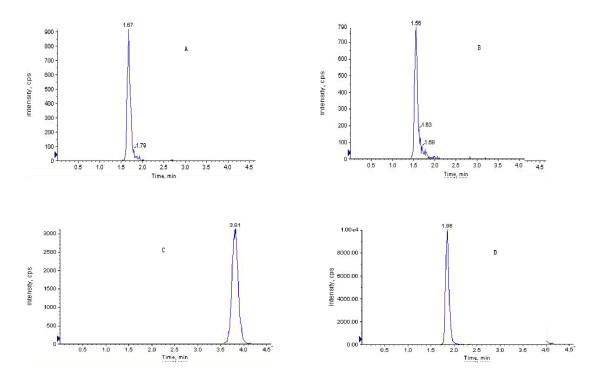
Chromatograms under LC/MS/MS conditions for analyzing beagle dog plasma spiked with Notoginsenoside R1 (A), Ginsenoside Rg1 (B), Ginsenoside Rb1 (C) and internal standard glipizide (D). MS/MS transitions monitored in the positive ion mode were from m/z 1007 to m/z 423 for R1 (MW 932), from m/z 875 to m/z 423 for Rg1 (MW 800), from m/z 1183 to m/z 487 for Rb1 (MW 1108), and from m/z 494 to m/z 369.1 for internal standard. Intensity cps: ion intensity is in counts per second. The retention time is 1.67 min for R1, 1.56 min for Rg1, 3.81 min for Rb1 and 1.86 min for I.S.